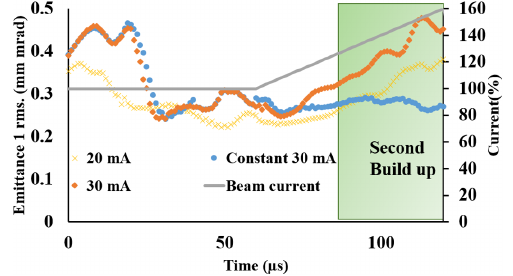
FIG. 11. Beam emittance evolution in time recorded at the end of the line when the beam current is growing.